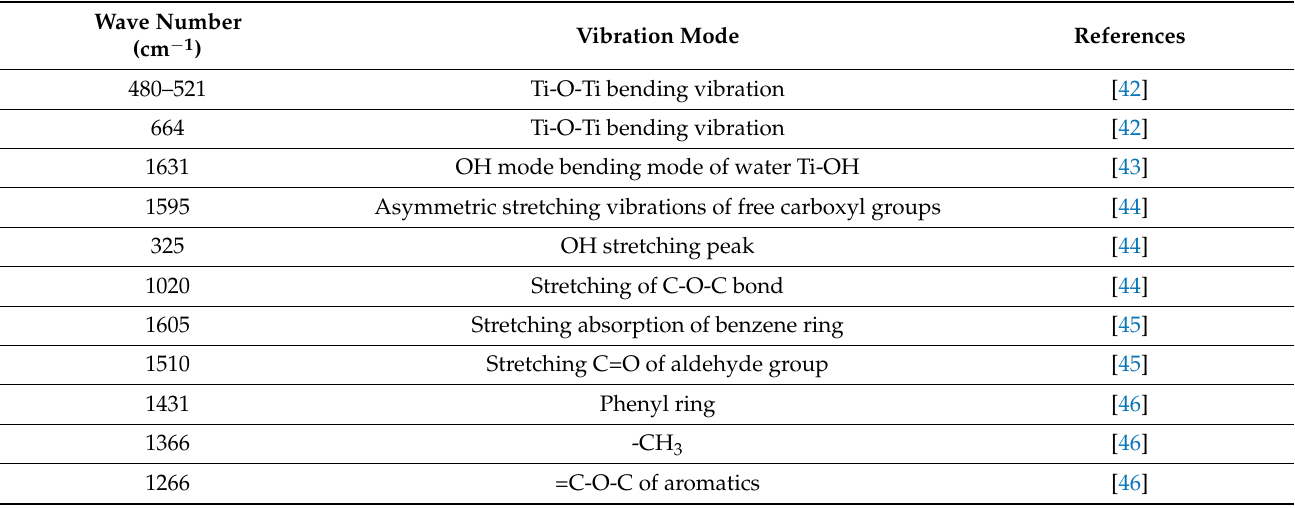
Table 1. Peak values and functional group vibrational modes obtained from microspheres and TiO 2 nanoparticles.